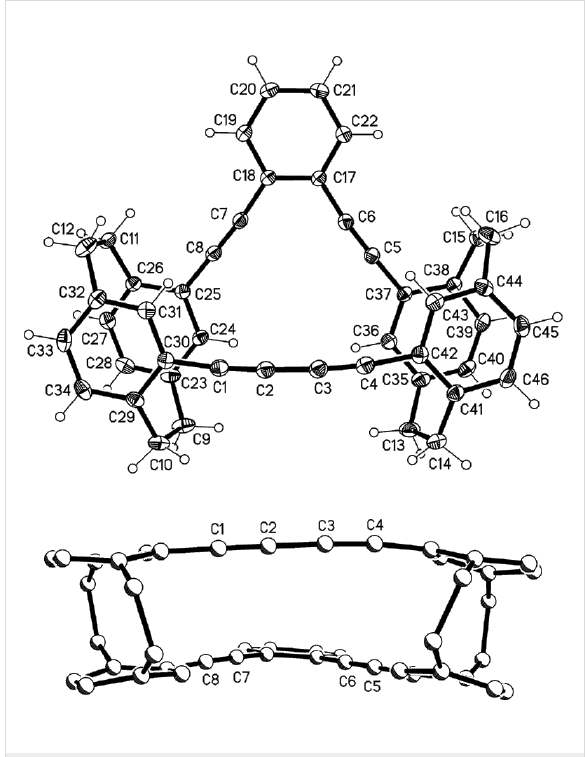
Figure 3: Above: The molecule of compound 19 in the crystal; ellip- soids represent 50% probability levels. Solvent is omitted for clarity. Below: Alternative view direction (arbitrary radii, without H atoms) showing the “parallel” geometry via the additional